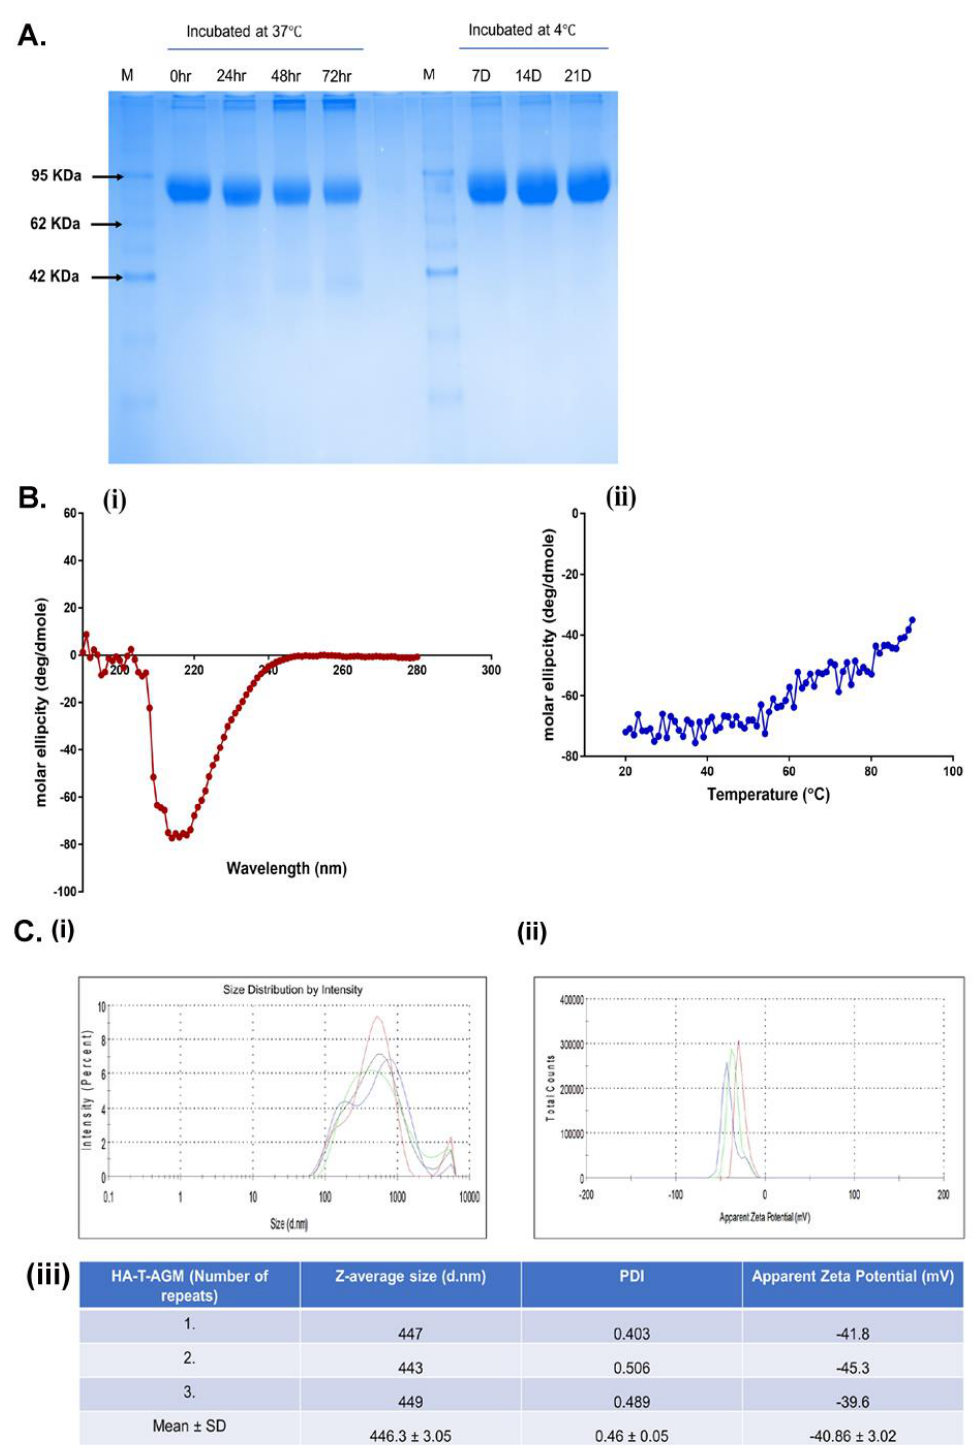
Figure 3. Biochemical and biophysical characterization of HA-T-AGM. ( A ): Thermostability profile of the protein after incubation at temperature for hours at 37 ◦ C and days at 4 ◦ C. ( B ) ( i , ii ): CD spectroscopy of HA-T-AGM protein. ( i ) Far-UV CD spectra in the wavelength range of 195–280 nm. ( ii ) Thermal unfolding of HA-T-AGM as monitored from 25 to 90 ◦ C. ( C ): Biophysical characterization of the synthesized HA-T-AGM protein. ( i ) Size distribution profiling, and ( ii ) Apparent zeta potential distributions of the HA-T-AGM protein. ( iii ) Statistical analysis and quantifications of the size diameters and zeta potentials. Here, different colors in the graph represent three independent experiments.